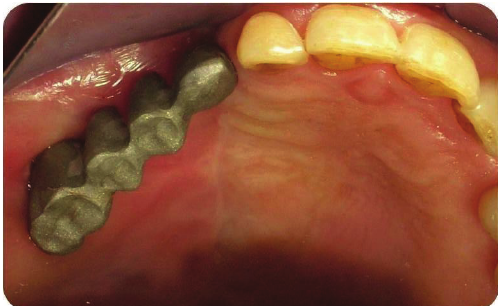
Figure 8: Fabricated Metal base of bridge.